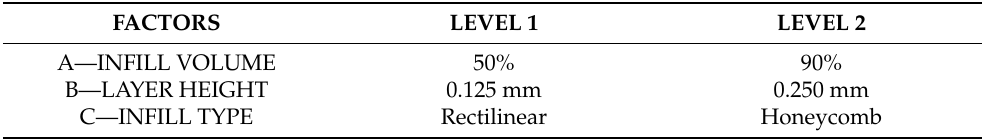
Table 1. Factors and levels for design of experiment for tensile strength testing.